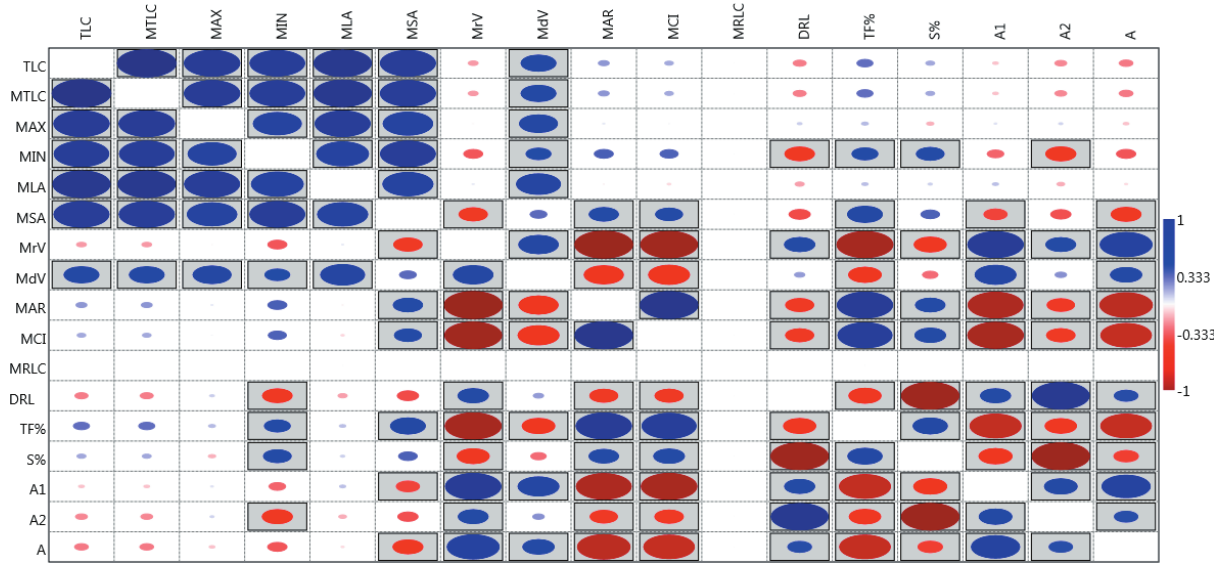
Figure 4. Correlation analysis between karyotype